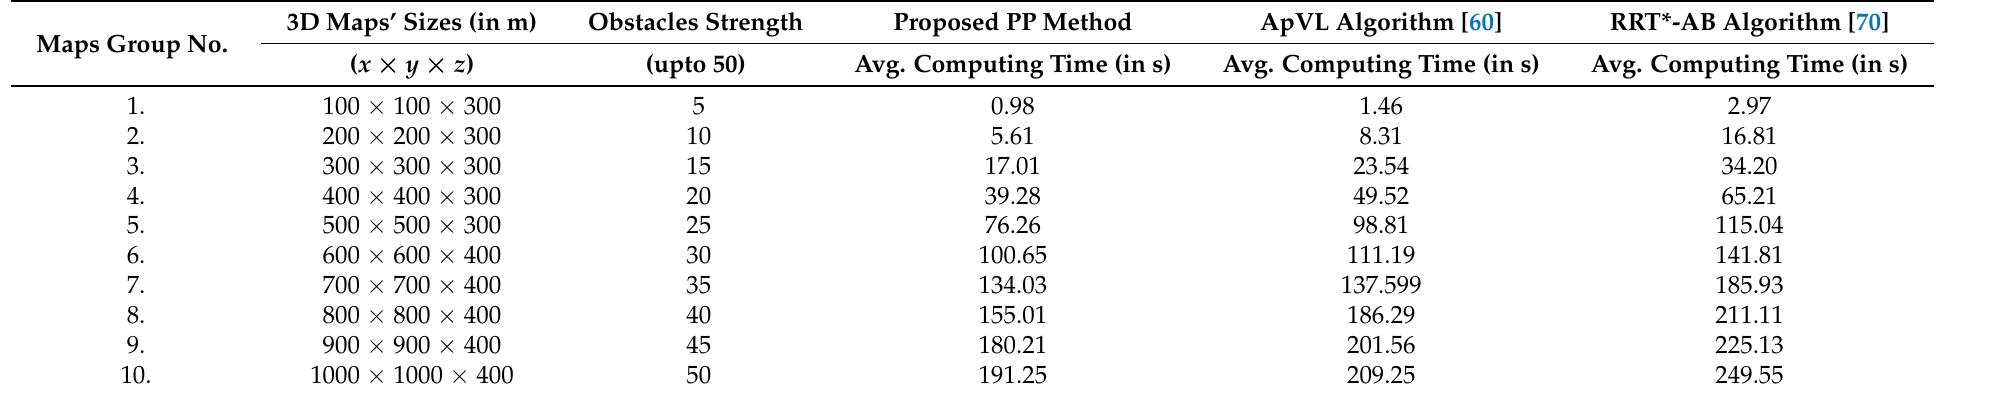
Table 1. Details of the 3D maps used in simulations and comparisons of task modeling